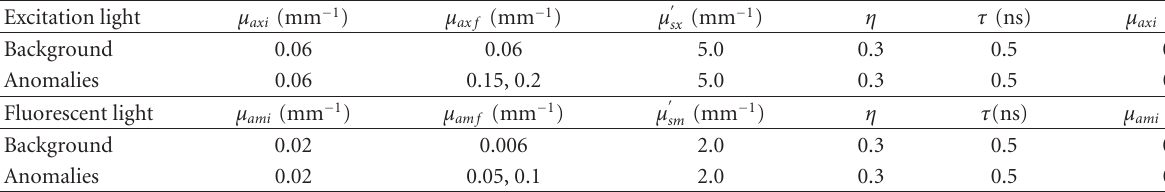
Table 1: Optical and fluorescent properties.